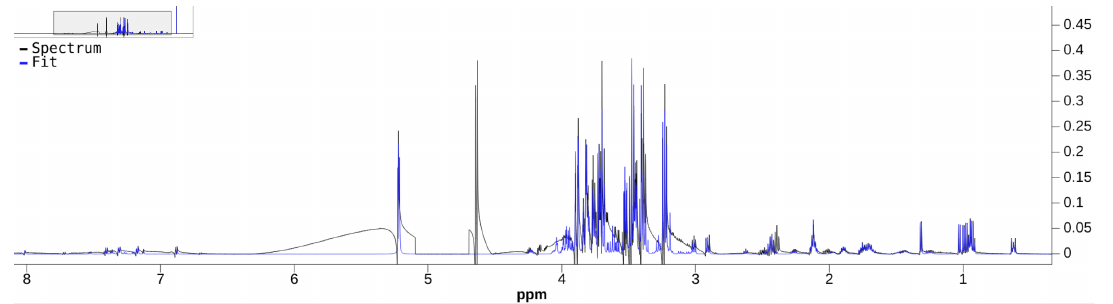
Figure 4. Reconstructed spectrum (blue, label: fit) vs. the preprocessed data spectrum (green, label: spectrum). Some signifi- cant artifacts are visible in the preprocessed data spectrum.